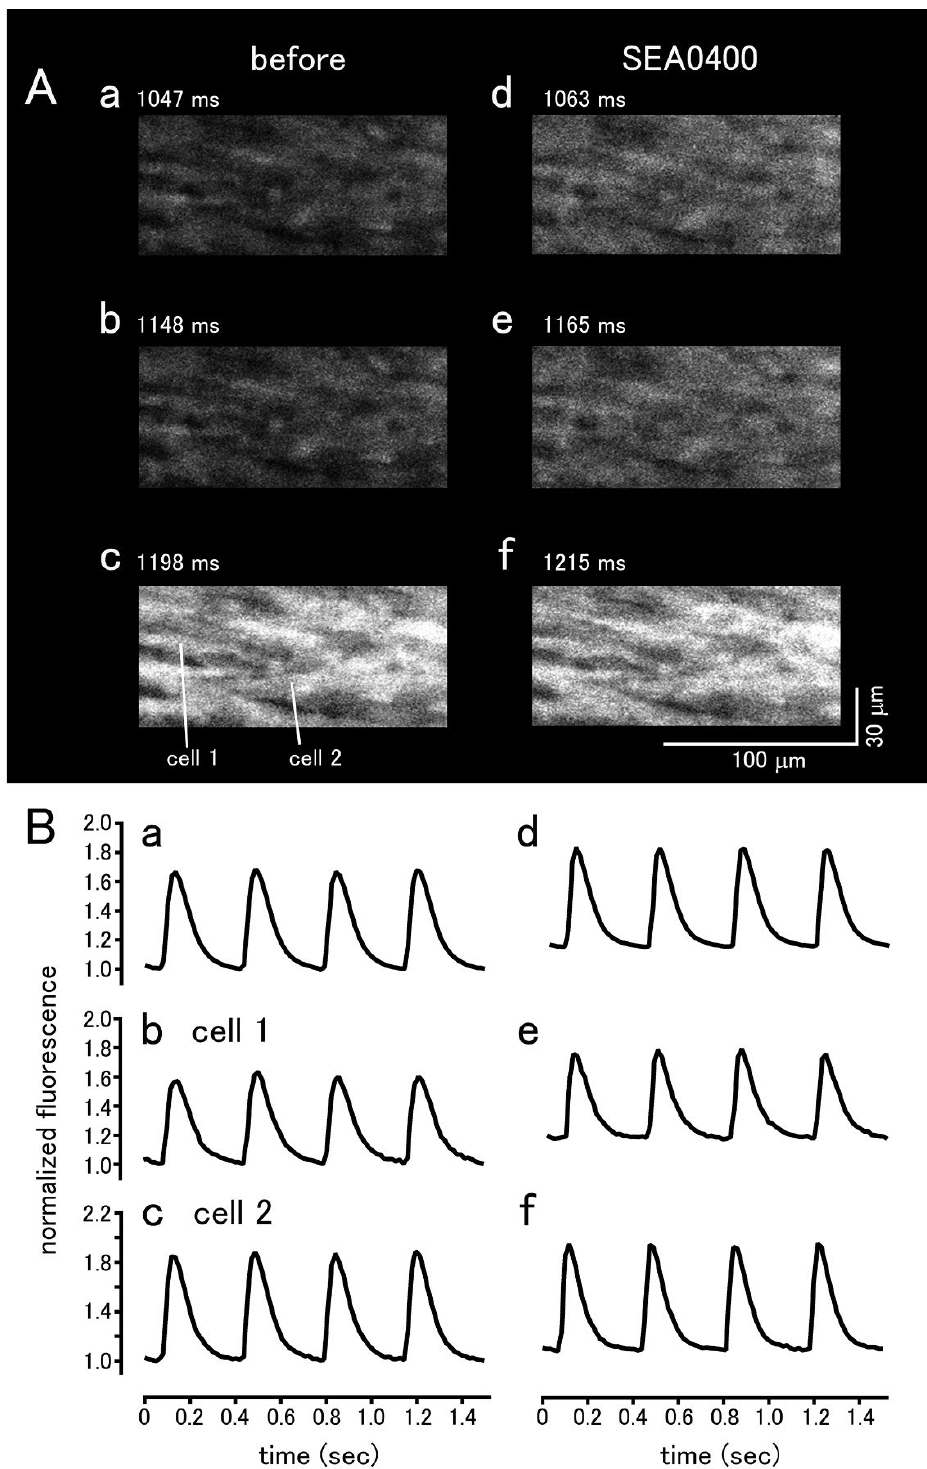
Figure 6. Effect of SEA0400 on spontaneously occurring Ca 2+ transients in the guinea pig sinus node tissue. ( A ) Typical x-y images of the myocardium loaded with Cal-590 before ( a – c ) and 10 min after the addition of 1 µ M SEA0400 ( d – f ). Panels c and f are the images at the peak of the Ca 2+ transient. Note that no Ca 2+ oscillation was observed during the interval between the Ca 2+ transients ( a , b , d , e ). ( B ) Time course of the changes in fluorescence before addition ( a – c ) and 10 min after the addition of 1 µ M SEA0400 ( d – f ). Time course of the fluorescence intensity quantified in the whole field of view ( a , d ), cell 1 ( b , e ), and cell 2 ( c , f ) as shown in panel ( A )/( c ).